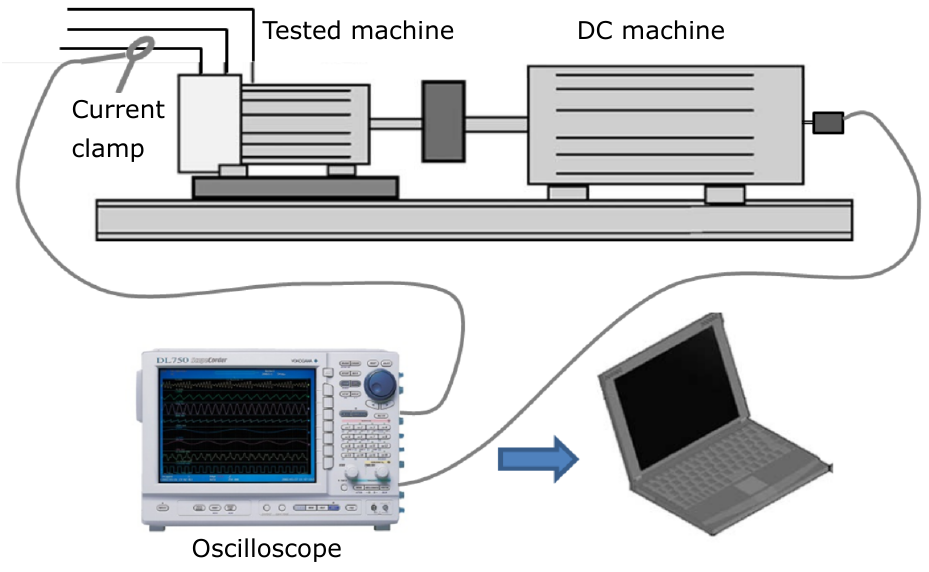
Figure 8. Schema of the test